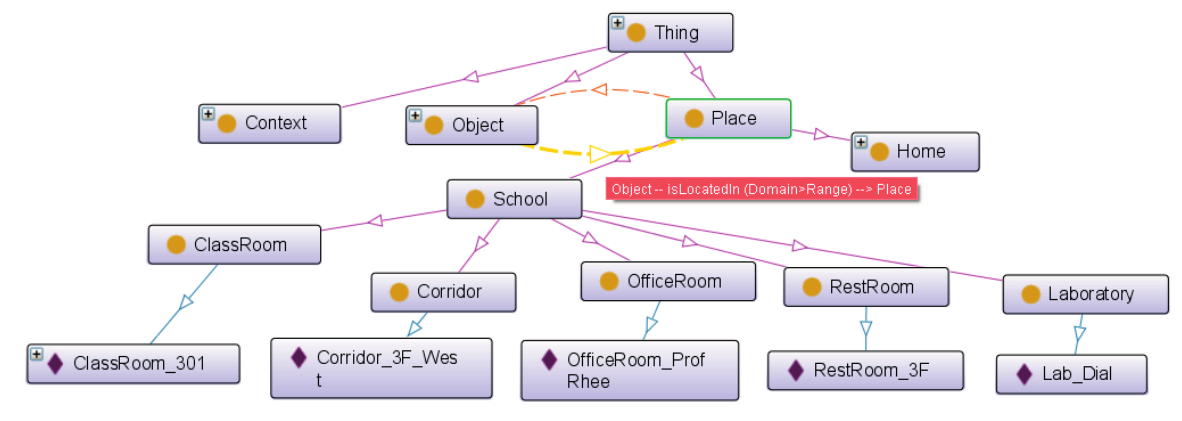
Figure 13. Base ontology (Place